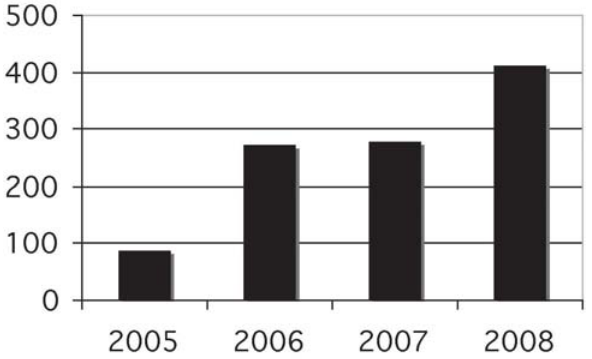
Fig. 1 - Número de pacientes adultos operados no InCor - DF por ano desde a primeira cirurgia cardíaca em paciente adulto, em maio de 2005